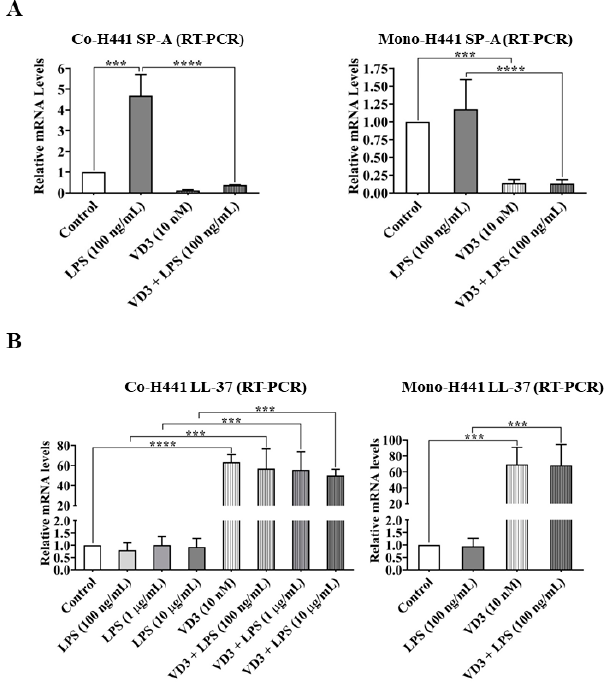
Figure 5. mRNA levels of SP-A and LL-37 in NCI-H441 cells. ( A ) mRNA levels of SP-A in NCI-H441 cells from the co-culture of NCI-H441/OECs and mono-culture of NCI-H441 cells treated with VD 3 (10 nM) and LPS (100 ng/mL). ( B ) mRNA levels of LL-37 in NCI-H441 cells from both the co-culture of NCI-H441/OECs treated with VD 3 (10 nM) and different doses of LPS (100 ng/mL, 1 µ g/mL, 10 µ g/mL) and the mono-culture of NCI-H441 cells treated with VD 3 (10 nM) and LPS (100 ng/mL). The mRNA levels were analyzed through real-time PCR. The values were shown as mean values ± SD from at least three independent experiments ( n ≥ 3). *** p < 0.001, **** p < 0.0001, one-way